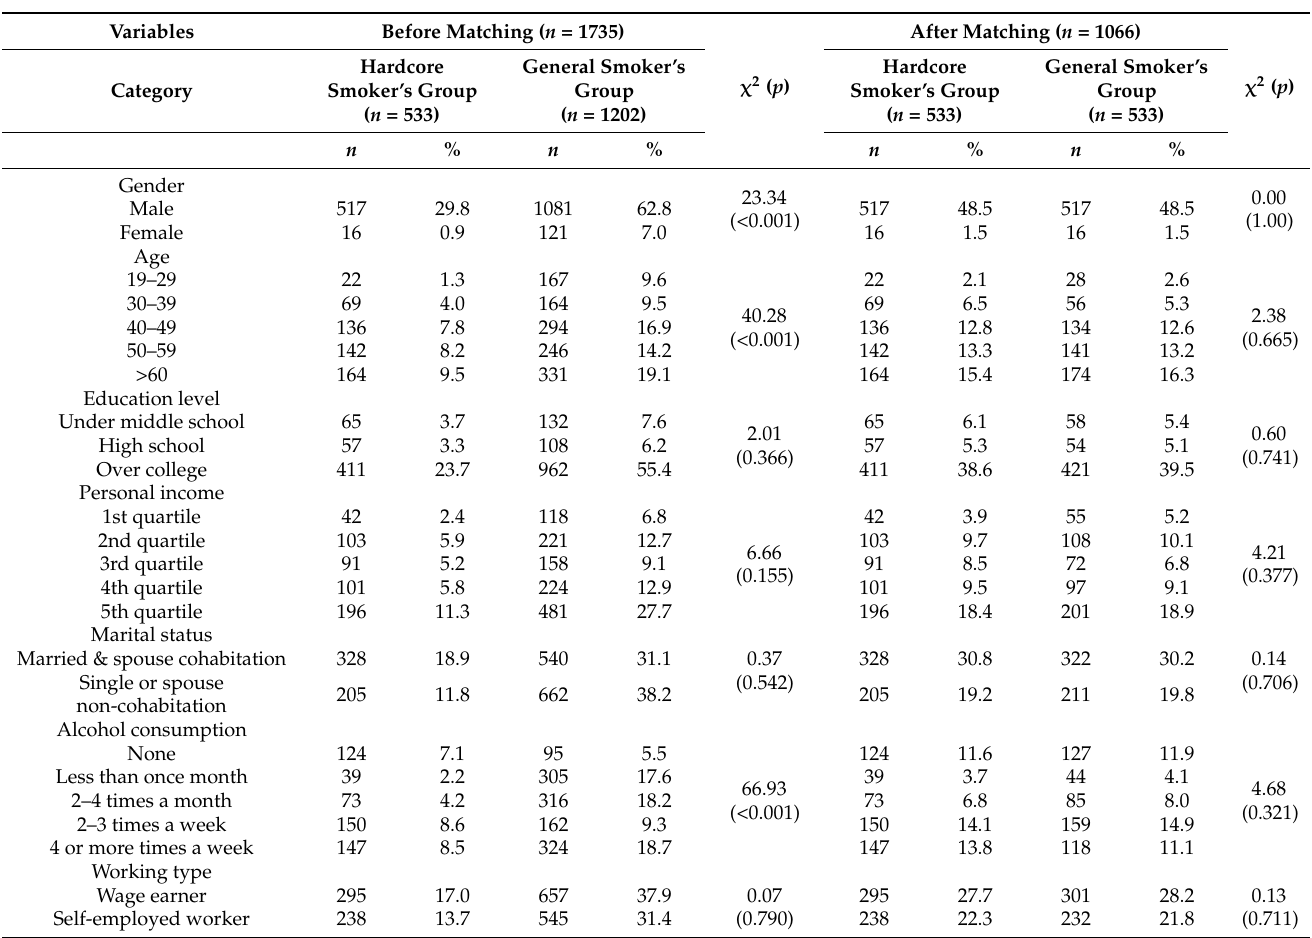
Table 3. Homogeneity of subjects’